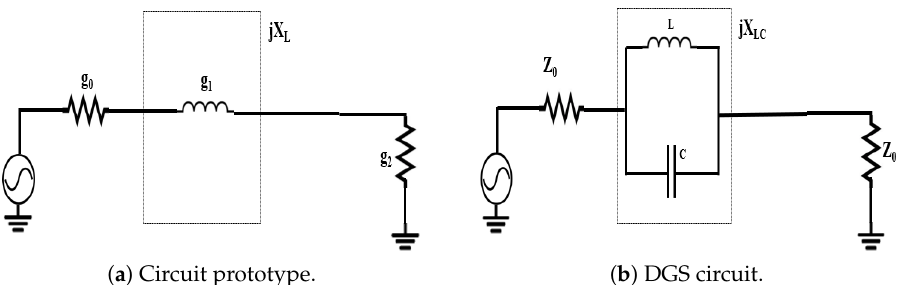
Figure 4. Equivalent circuits of one-pole Butterworth-type low-pass filter and